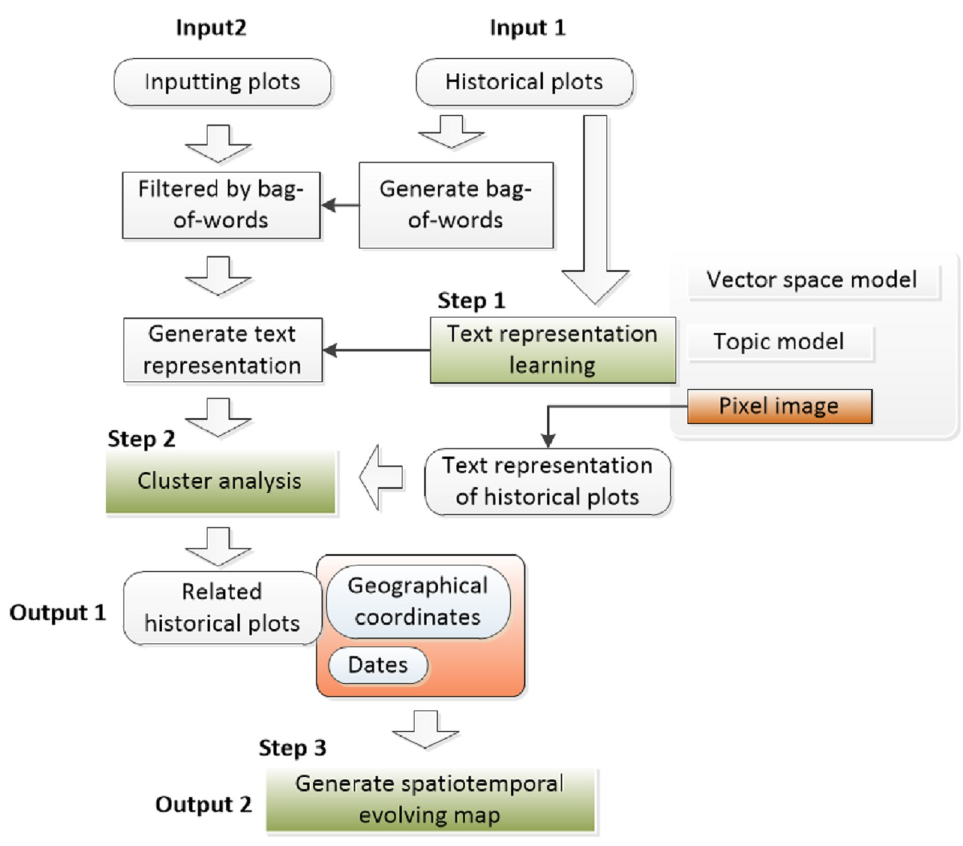
Figure 3. Modeling